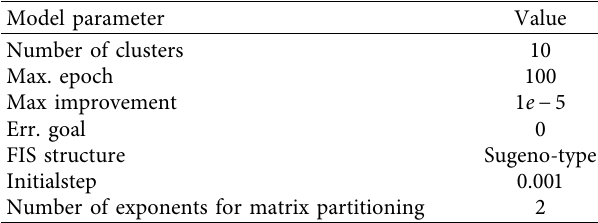
Table 1: Model Parameters for ANFIS